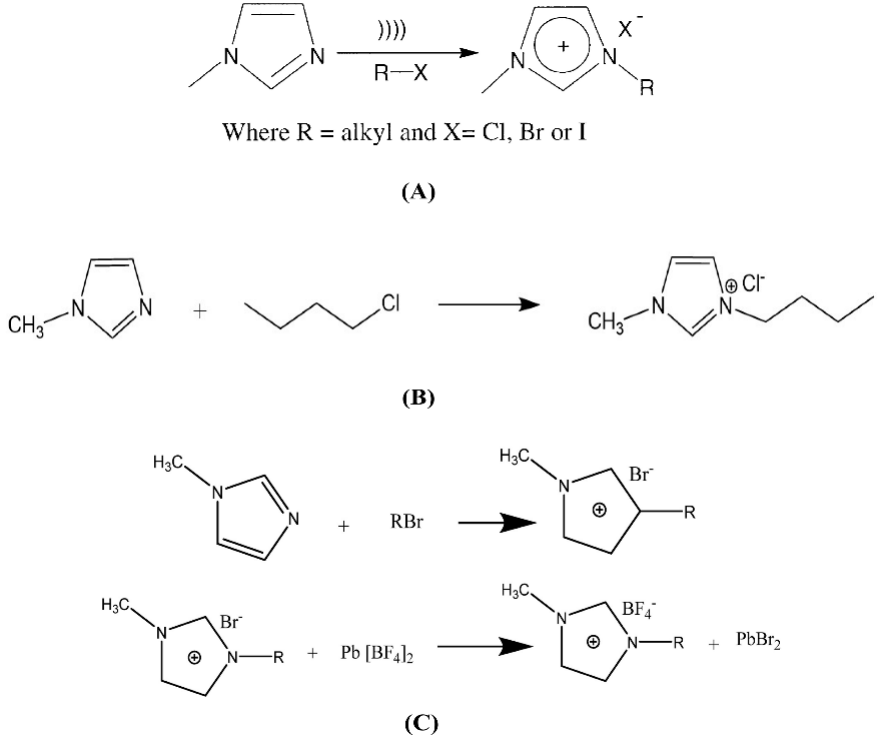
Figure 2. ( A ) An ultrasound-assisted preparation for a series of 1-alkyl-3-methylimidazolium hal- ides. Republish from Ref. [41], Copyright (2002), with permission from American Chemical